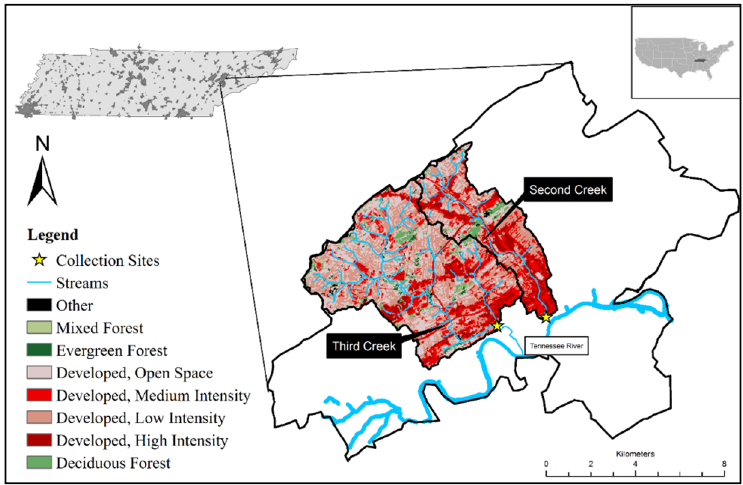
Figure 1. Study areas in Knoxville, TN, with 2011 National Land Cover Data.